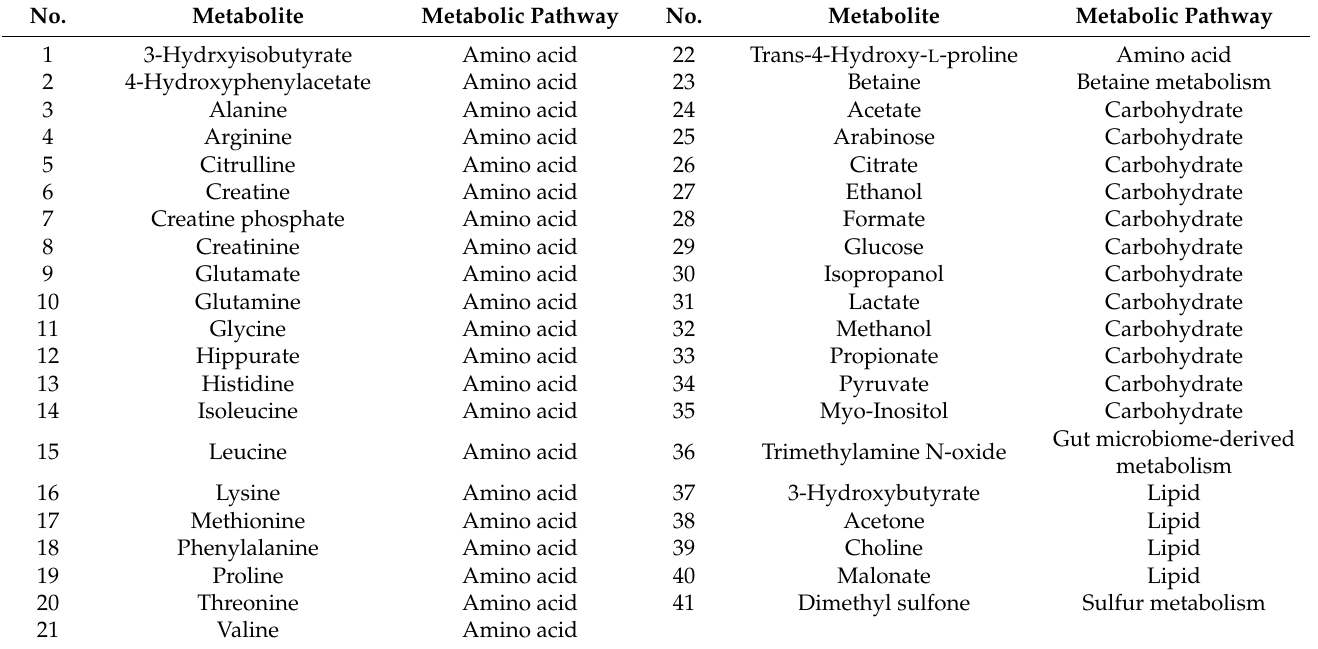
Figure 3. The serum metabolic profiling of Sanhe cattle. ( a ) The 1 H NMR spectra (0–10.0 ppm) of serum from Sanhe cattle. The numbers represent signals of equivalent hydrogen, and the DSS is 0 ppm for the chemical shift of the whole spectrum. ( b ) Forty-one unique metabolites were commonly identified and quantified in the serum metabolic profiling of Sanhe cattle. Table 1. Forty-one metabolites and their metabolic pathways in the serum of Inner-Mongolia Sanhe cattle.